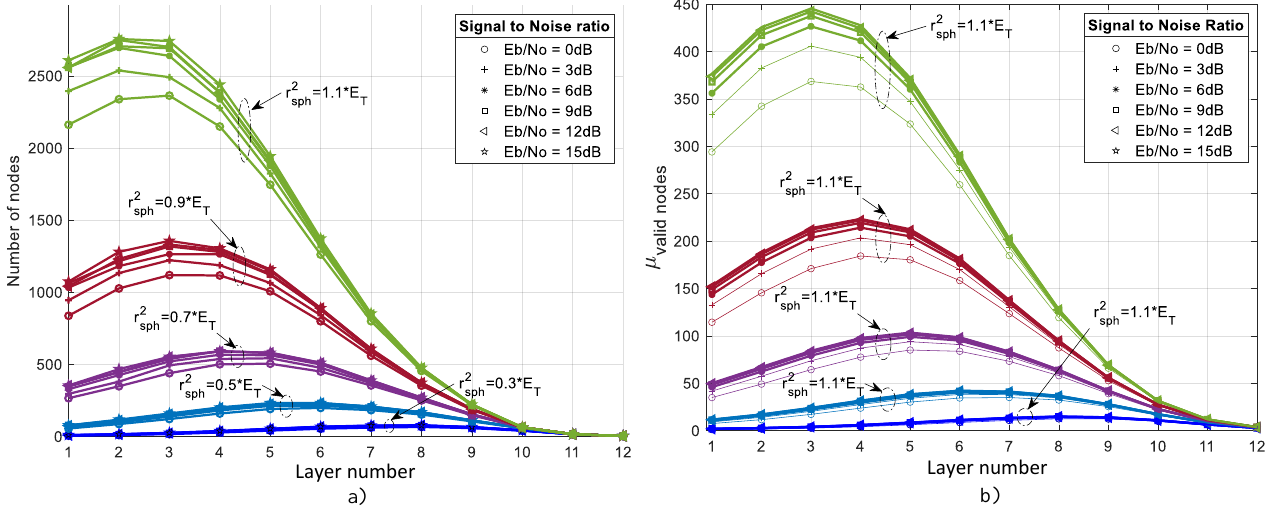
Figure 3. (a) The number of nodes corresponding to cumulative distribution of 99 . 999% coverage of all available valid node; (b) the mean ( µ ) of valid search nodes in each level of SD search tree in 16-QAM 8 × 8 MIMO system. Simulated for 1 million random node input patterns with